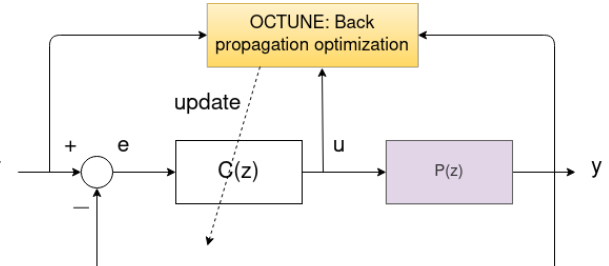
Figure 2. A feedback system with controller C ( z ) coefficients updated by the OCTUNE algorithm. The OCTUNE algorithm receives the reference, actual, and controller output signals and performs update operations to update the controller